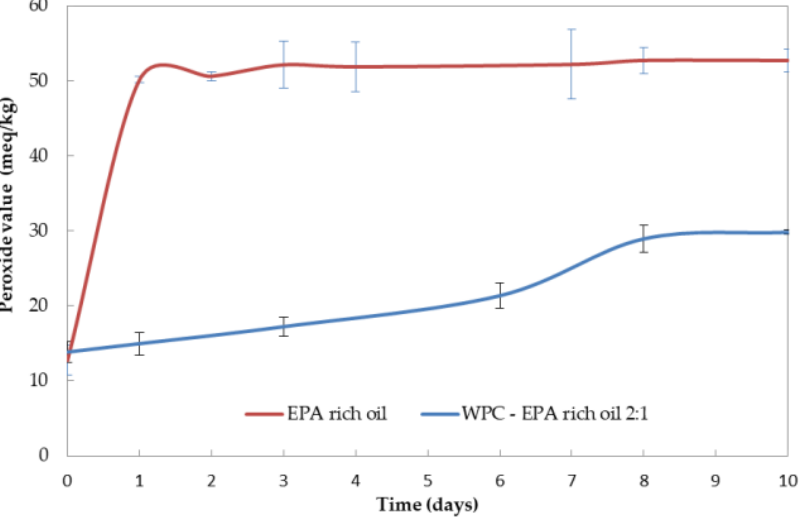
Figure 3. Evolution of the peroxide value of non-encapsulated EPA-rich oil compared with the EPA-loaded WPC microparticles.